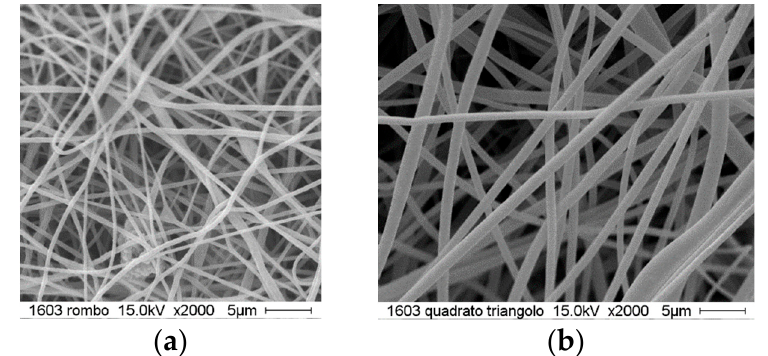
Figure 2. Produced nanofibers: ( a ) PVDF and ( b ) PSF.